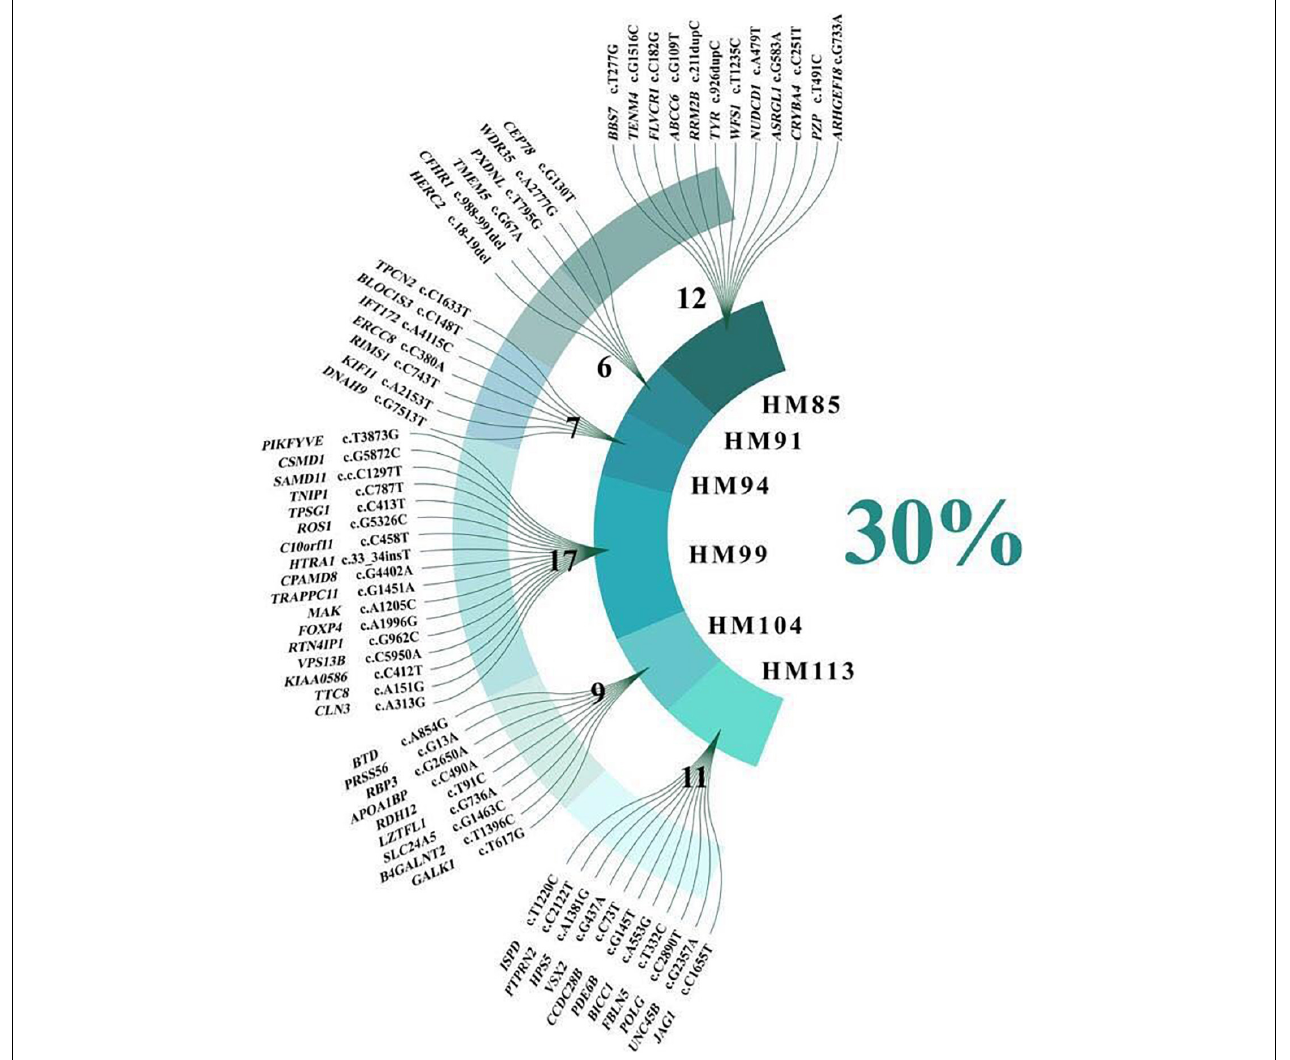
FIGURE 2 | Sixty-two variants related to high myopia and ocular disease that were not cosegregated with high